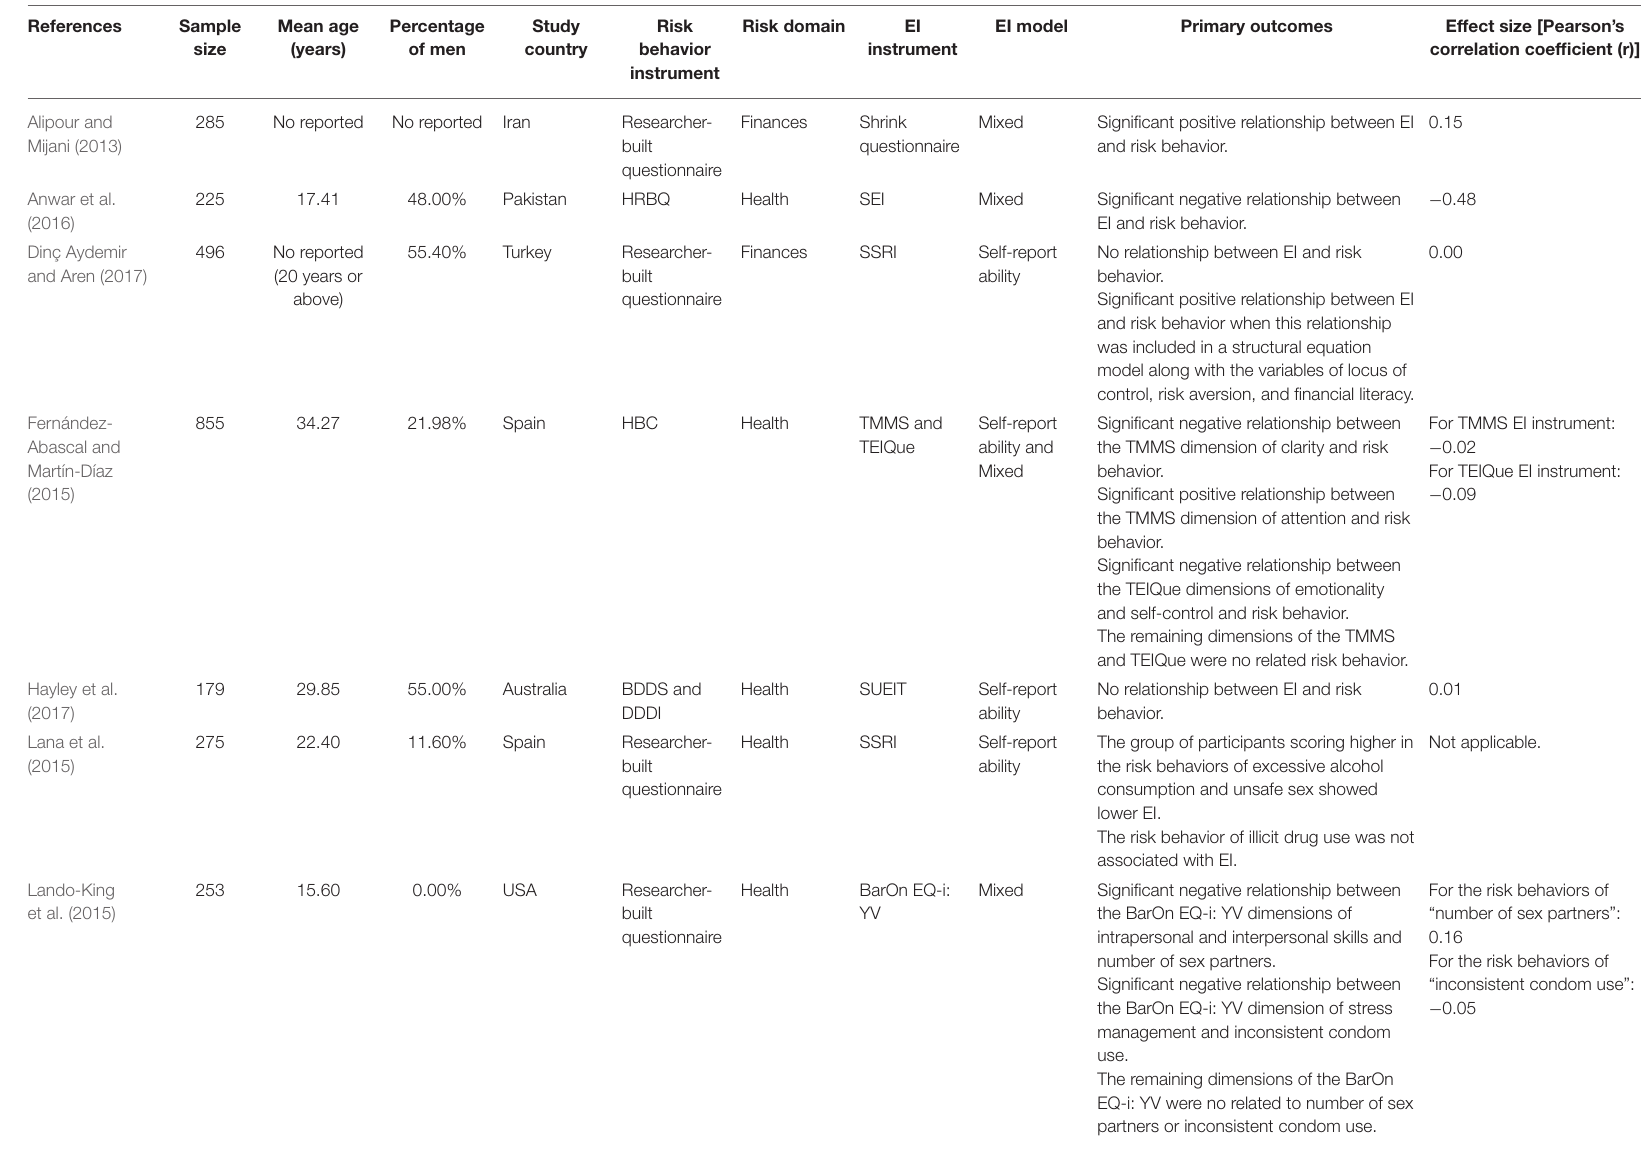
TABLE 1 | Main characteristics of the studies included in the systematic